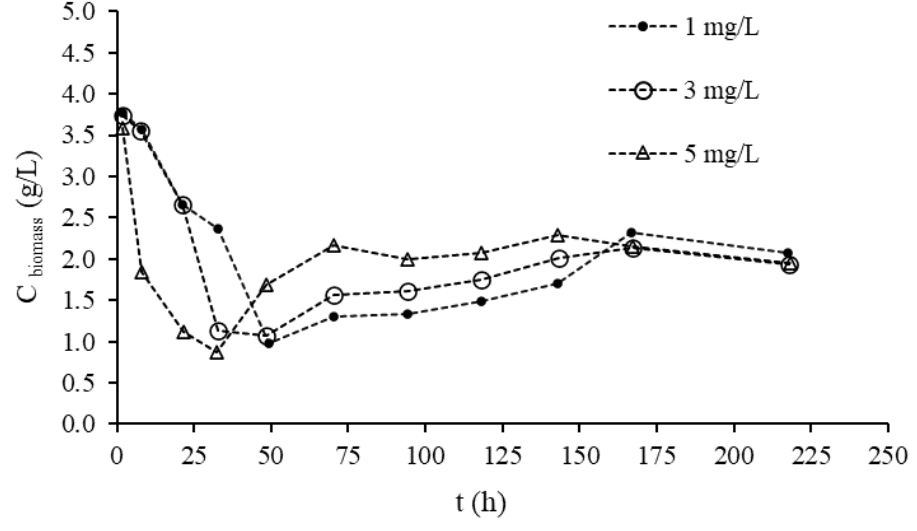
Figure 5. Concentration of R. viscosum biomass as a function of time for the biodegradation experi- ments.